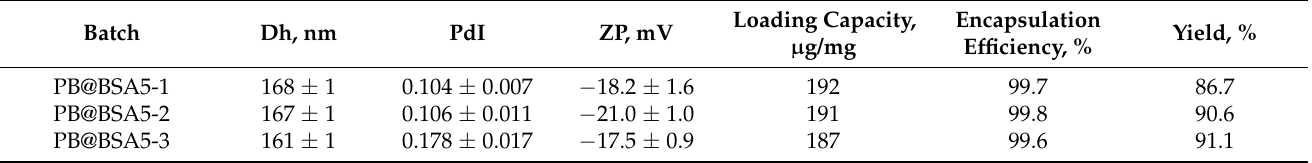
Table 2. Properties of three batches of PB@BSA5 nanoparticles.